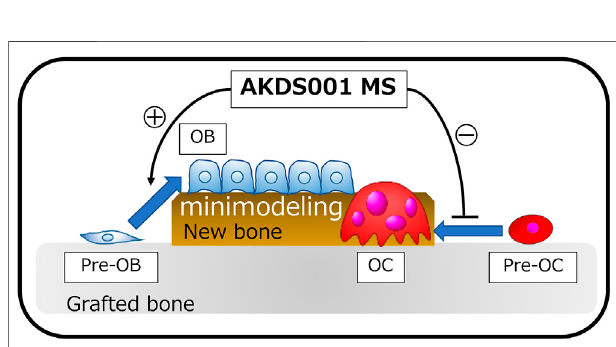
FIGURE 9 | Schemas showing the osteogenic mechanisms induced by AKDS001 MS. AKDS001 promotes osteoblast differentiation and inhibits osteoclast maturation, resulting in new bone formation by minimodeling. MS, microsphere; MSC, mesenchymal stem cell; OB, osteoblast; OC,